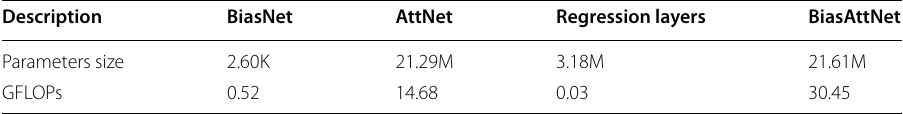
Table 4 Parameters sizes and GFLOPs of the proposed network